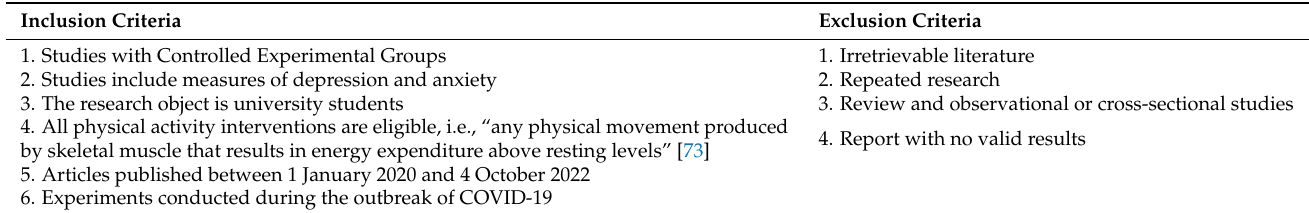
Table 1. Inclusion and